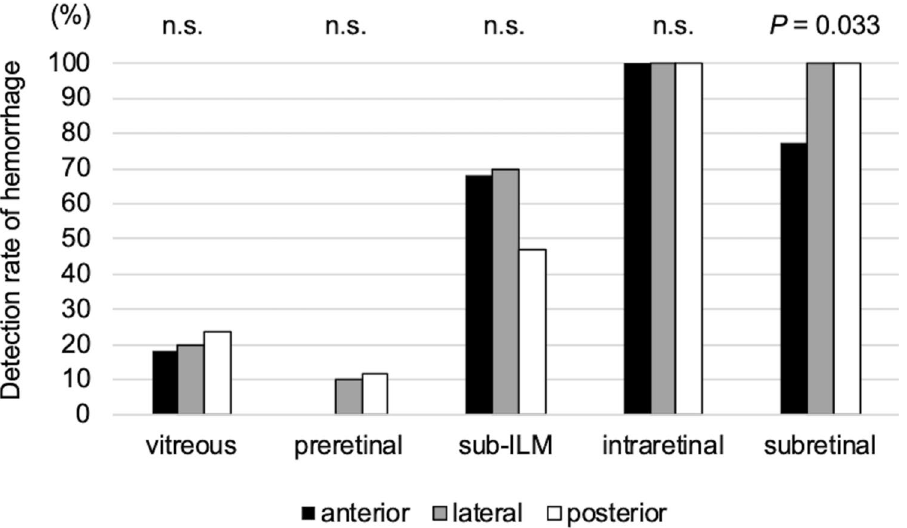
Figure 1. Association between the hemorrhagic pattern and the position of ruptured retinal arterial macroaneurysms relative to the affected retinal artery. The detection rate for sub-inner limiting membrane hemorrhage was not significantly associated with the depth of the ruptured retinal arterial macroaneurysm; however, the detection rate for subretinal hemorrhage was significantly lower for eyes with anteriorly ruptured RMAs ( P =